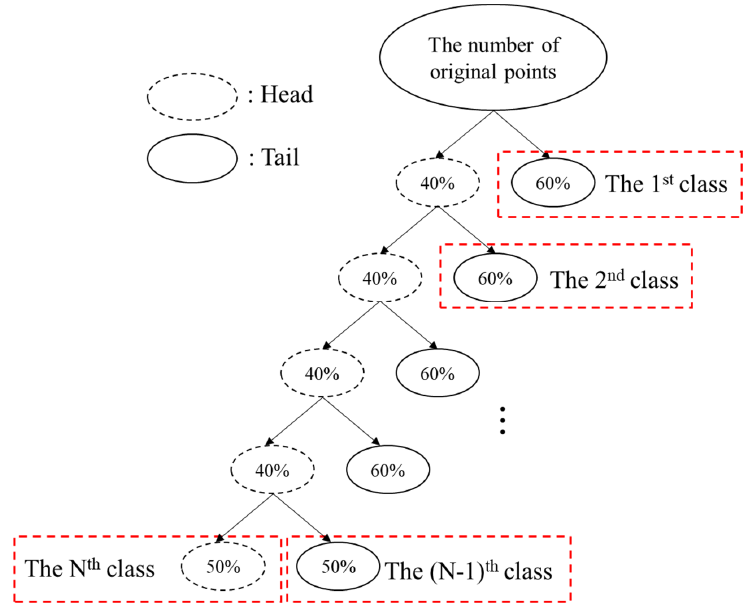
Figure 5. The process of classification, which uses the concept of head and tail breaks.